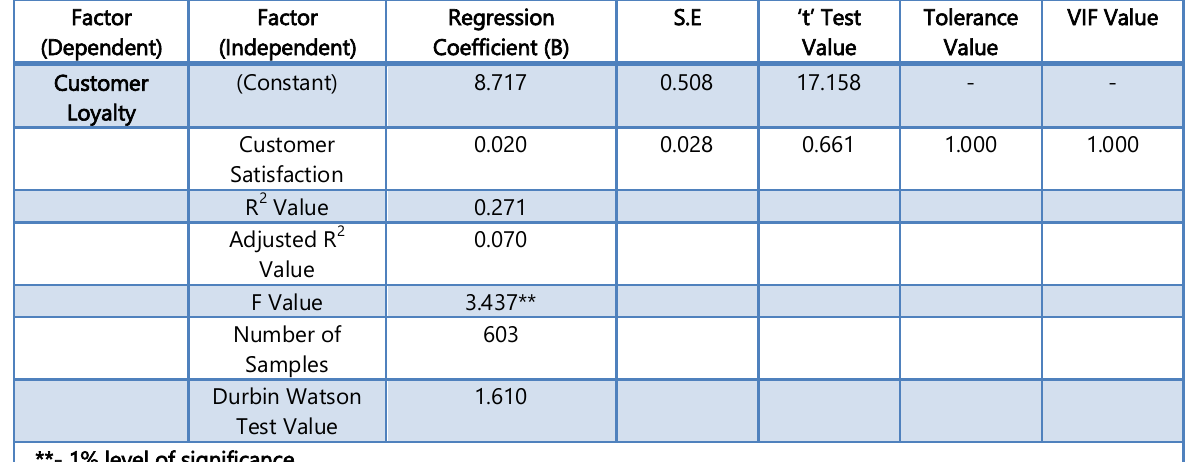
Table 5: Details of Regression Coefficient and the Statistics for the Proposed Model of the Study (Source: Authors‟